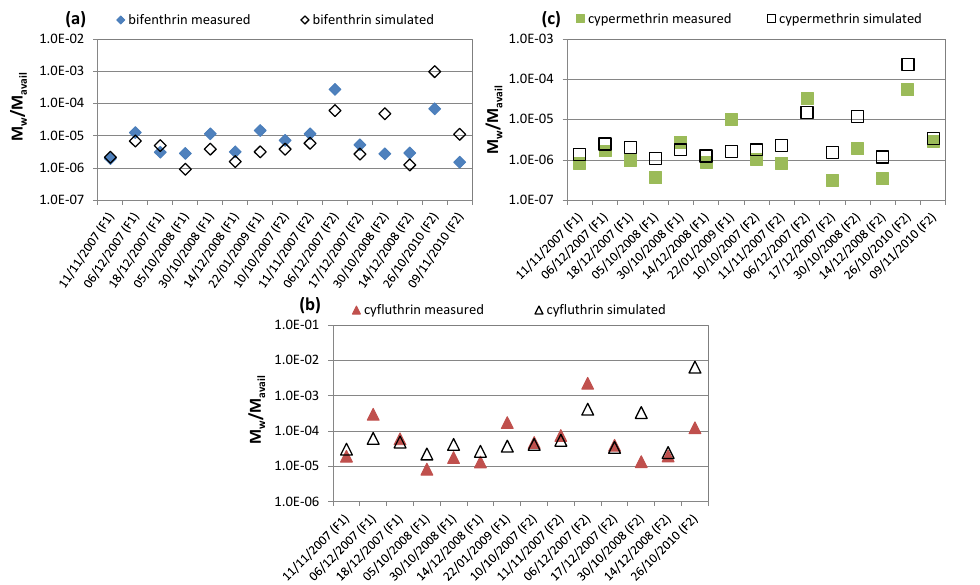
Figure 8. Comparison between the measured and simulated fraction of mass washed off and mass available to wash-off of ( a ) bifenthrin, ( b ) cyfluthrin, and ( c ) cypermethrin.